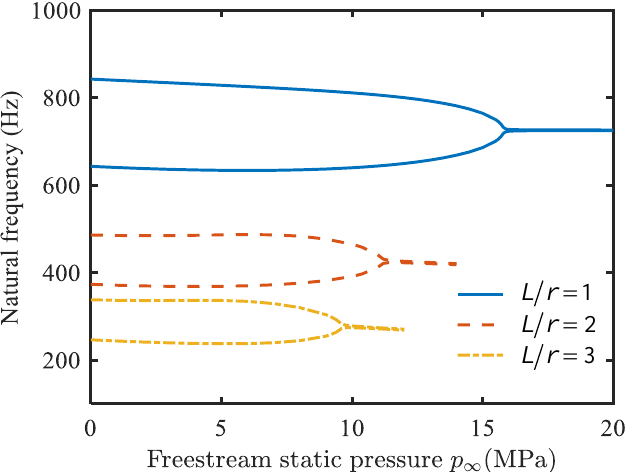
Figure 8. Influence of the length-to-radius ratio of the conical shell on critical free-stream static pressure ( p = 1).